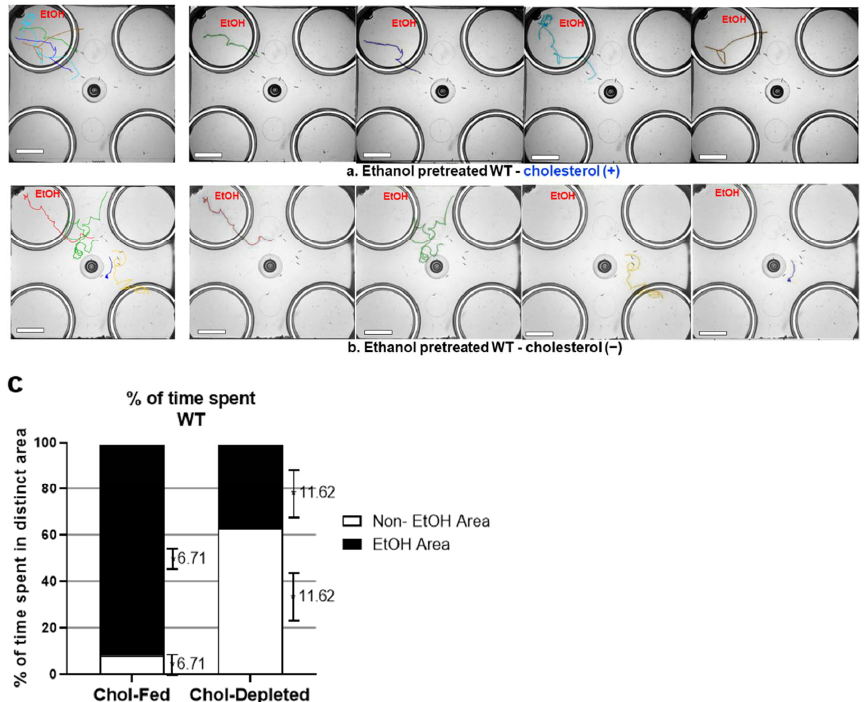
Figure 1. Cholesterol-depleted WT animals explored the nonethanol area even after ethanol pretreatment while cholesterol-fed animals headed straight to and remained in the ethanol area. ( a ) Trajectories of individual WT animals, cholesterol-fed (ethanol-pretreated for 4 h on 300 mM of ethanol). ( b ) Trajectories of individual WT animals, cholesterol-depleted (ethanol-pretreated for 4 h on 300 mM of ethanol). Ethanol-pretreated animals were placed in the middle of the assay plate, which contained ethanol (300 mM) only in the top left well (red EtOH). All wells were marginally covered by media that allowed free motion between the areas. Scale bar = 10 mm. ( c ) Behavioral quantification of ( a , b ). Ethanol-pretreated WT animals (cholesterol-fed) spent more time in the ethanol area, whereas cholesterol-depleted WT animals explored the nonethanol area more, even when ethanol-pretreated under the same conditions. These data were analyzed employing a chi-square test, which indicated df 66.42 and 1 z 8.150, p < 0.0001. Error bars shown to the right of each section (ethanol area or non-ethanol area) of the bar graph is SEM (N = 6, cholesterol-fed; N = 14,